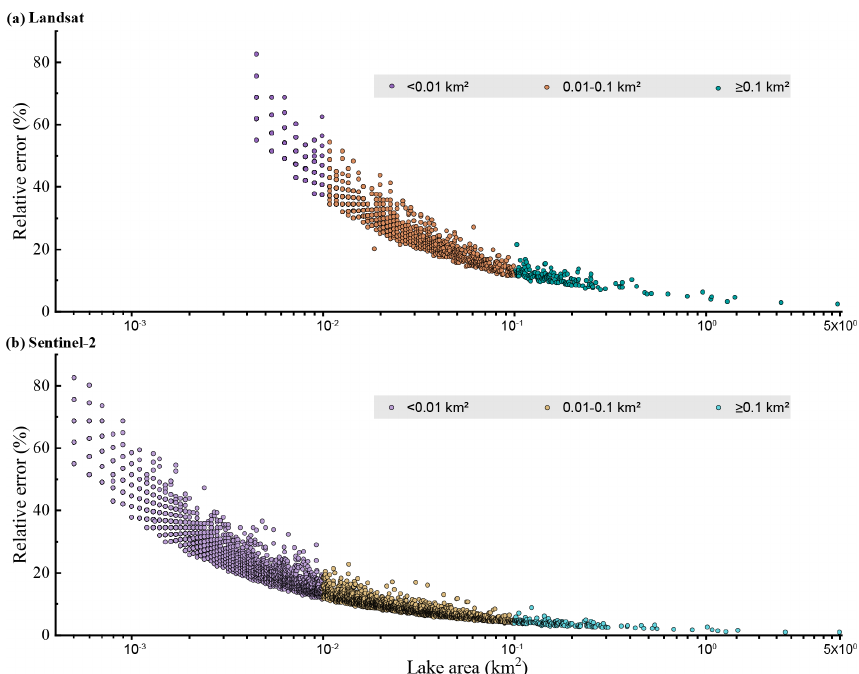
Figure 8. The estimated relative error for glacial lakes of all or specific size ranges in the study area. Error estimation is based on the modified equation and lake data extracted from Landsat (a) and Sentinel-2 images (b)